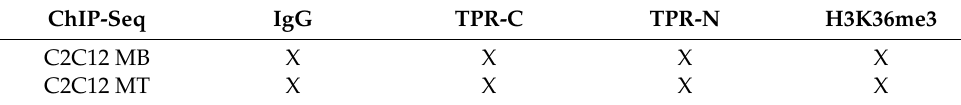
Table 2. Combination of the samples and antibodies for ChIP-Seq.